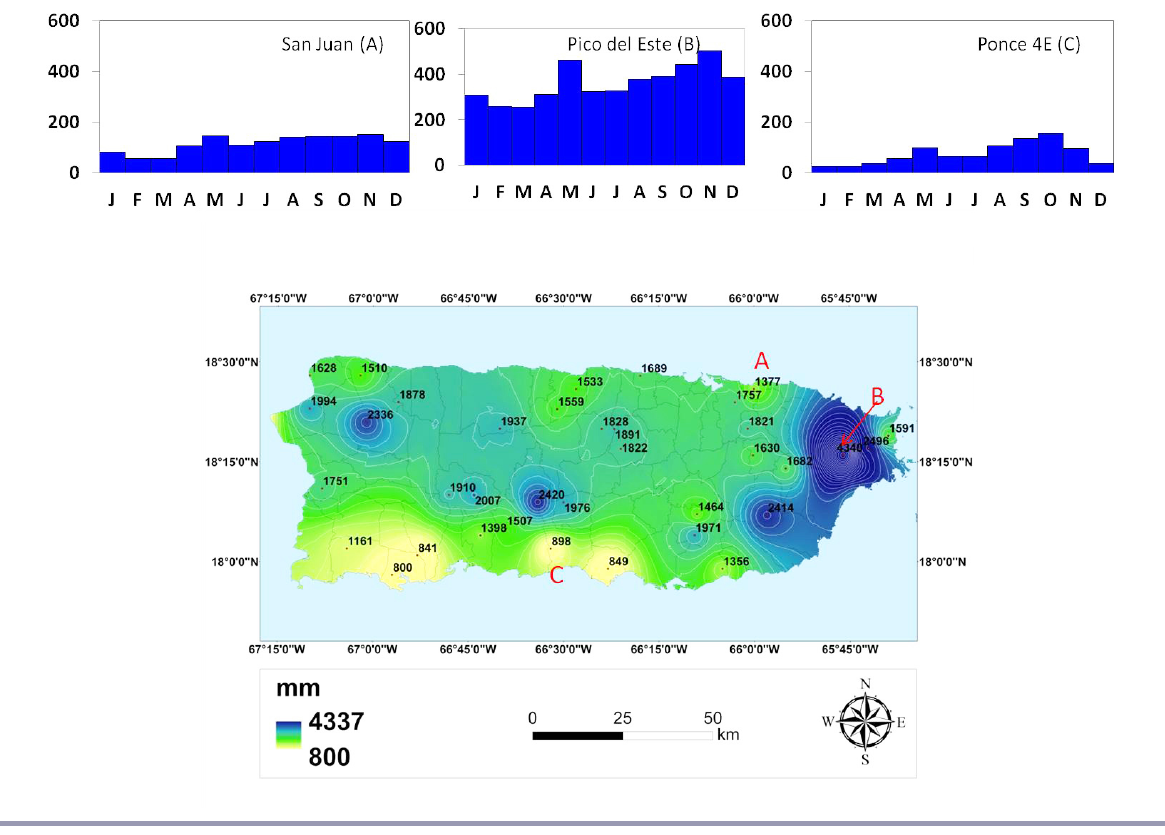
Fig. 1 . Annual rainfall distribution in Puerto Rico representing average monthly precipitation. The top three graphs show average monthly precipitation for weather stations at the San Juan Weather Service Forecasting Office, one near the City of Ponce, and another at Pico del Este peak in the Luquillo